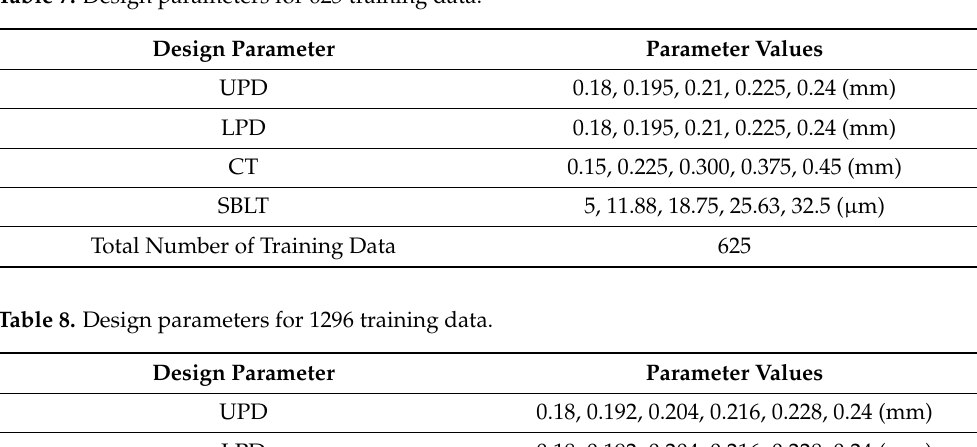
Figure 7. The diagram of WLP design parameters.